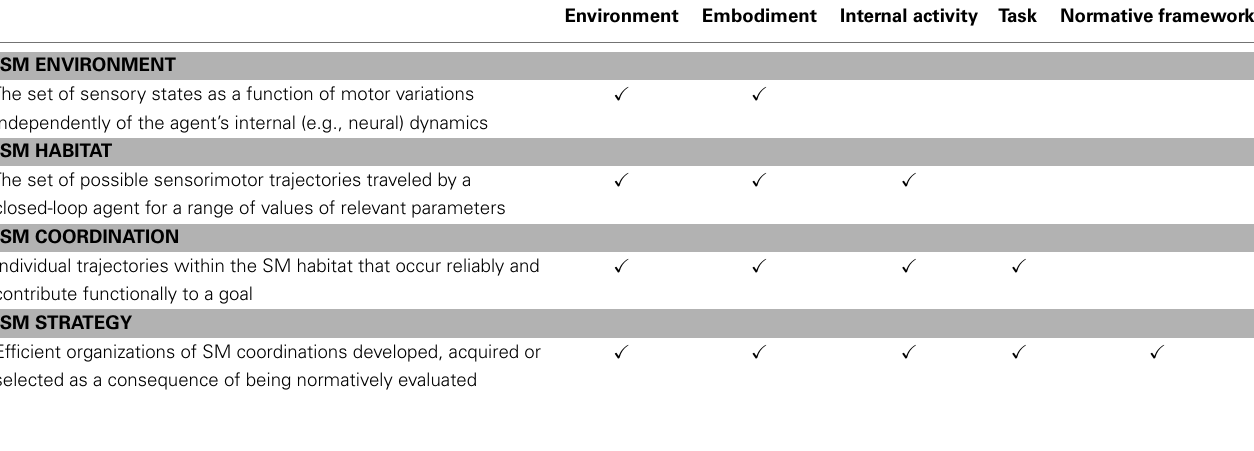
Table 1 | Summary of sensorimotor structures (SMCs) indicating dependencies on different